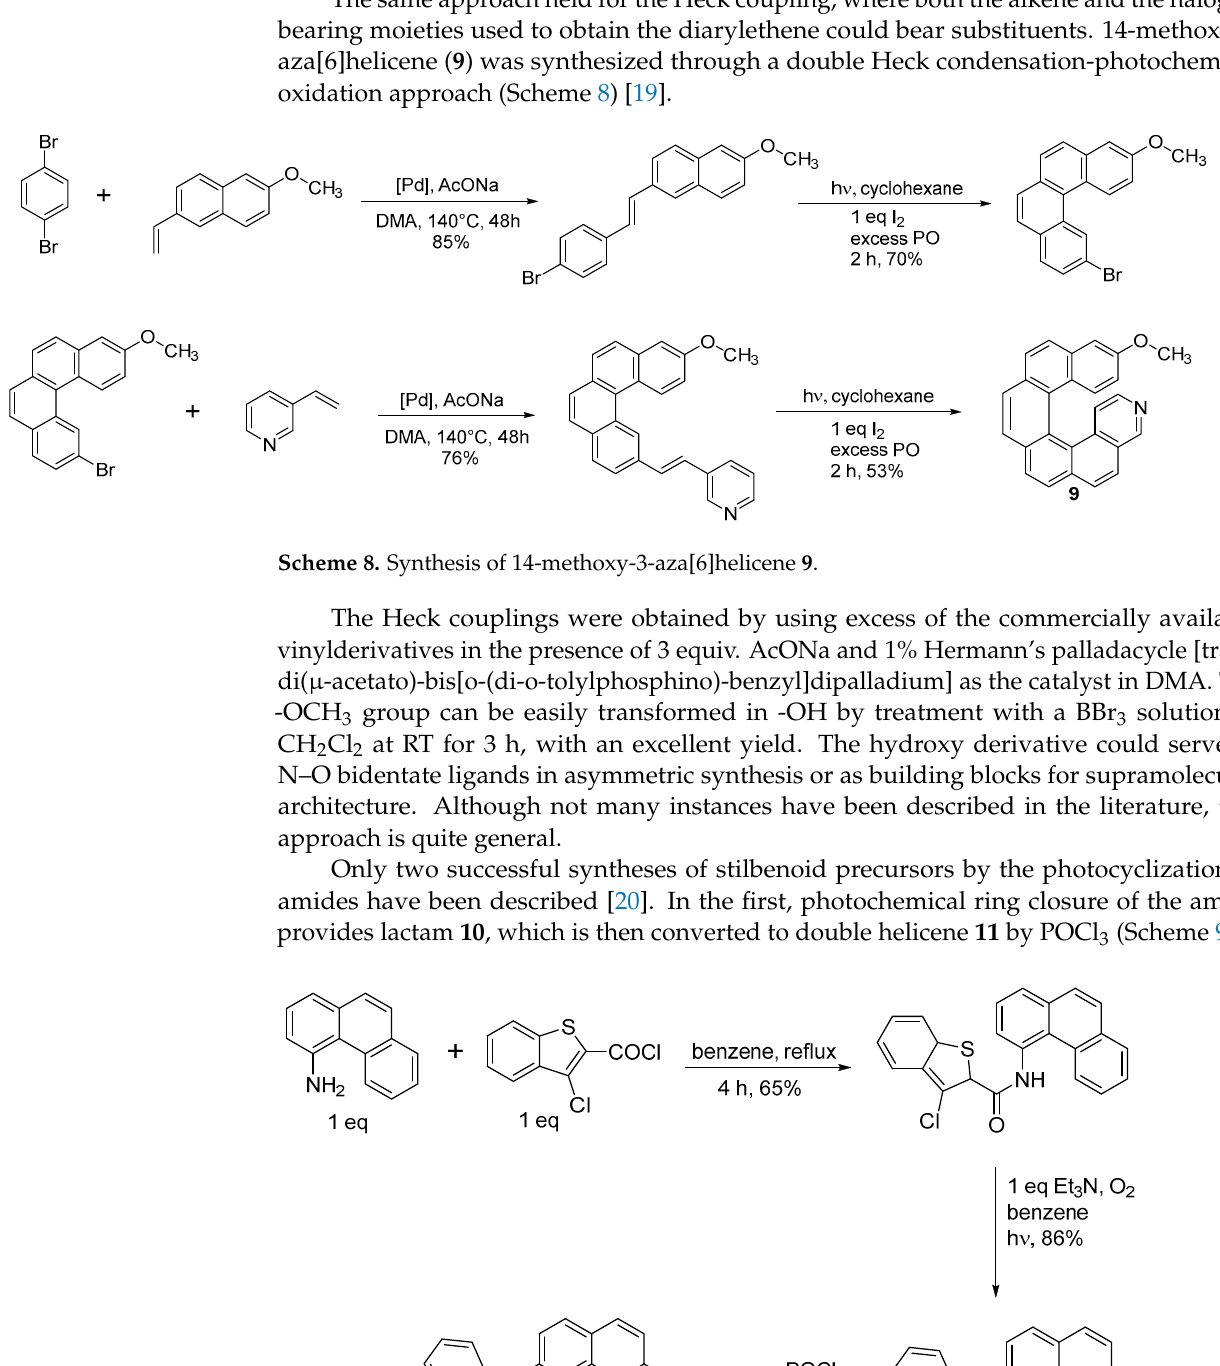
Figure 1. 8-chloronaphtho[2,1-h]thieno[3’,2’:4,5]thieno[2,3-c]quinoline. 2.2. [2 + 2 + 2] Cycloisomerization This approach to the synthesis of helicenes involves intramolecular [2 + 2 + 2] alkyne cycloisomerization catalyzed by Co I , Ni 0 , or Rh I to provide the simultaneous formation of three or more cycles in a single step, giving access directly to the desired helicene, or to its tetrahydro derivative, to be oxidised in a subsequent step. This strategy has been exten- sively used for the synthesis of electron-rich systems, namely carbo- and oxa-helicenes [21], while only limited examples are reported for electron-poor pyridine moieties (Figure 2). Ni°, Co I , Rh I Figure 2. Scheme of the general [2 + 2 + 2] cycloisomerization reaction (left); a nitrogen-containing helicenoid structure obtained in this way (right).